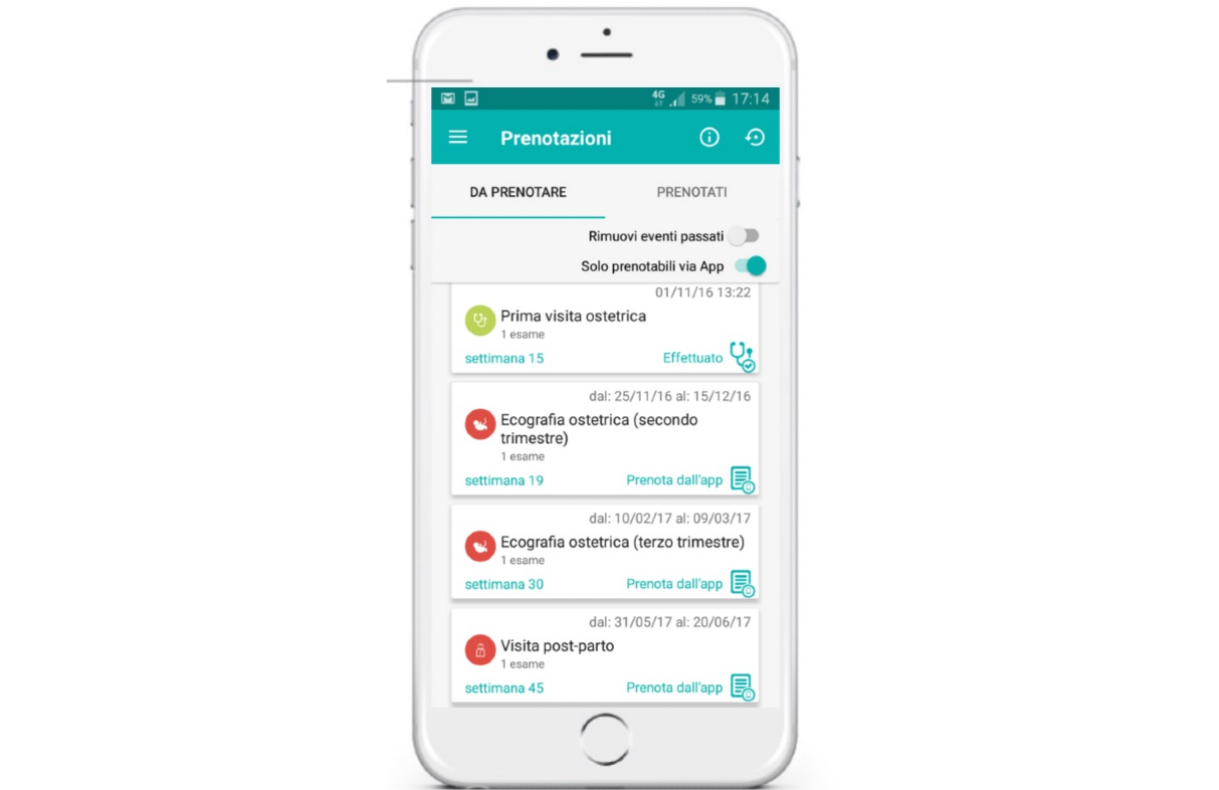
Figure 3. hAPPyMamma e-booking of visits and tests, integration into the app planner, and synchronization with the local health authority booking